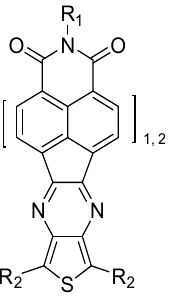
Figure 12. General structure of the fifth generation of oligothiophene–naphthalimide